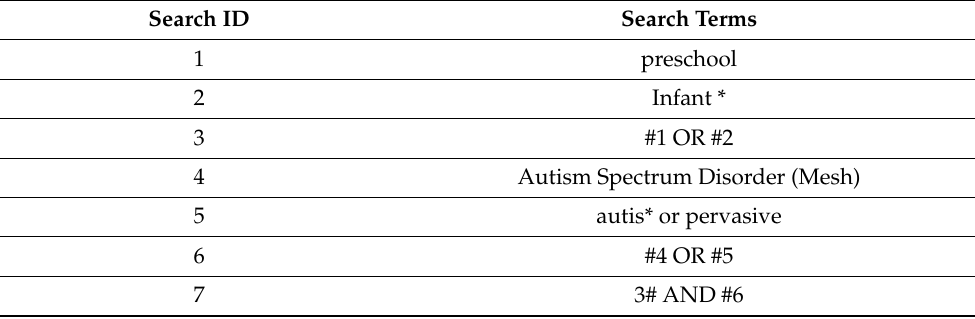
Table A3. Institute of Electrical and Electronics Engineers (IEEE) search terms.